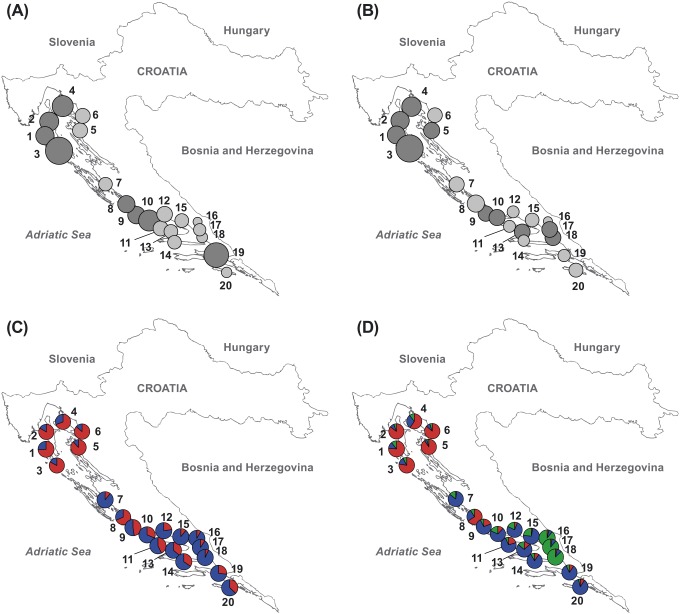
AFLP variation of Tanacetum cinerariifolium.A) Gene diversity (HE), B) Frequency down-weighted marker values (DW). In (A) and (B), the size of the circles is proportional to the depicted values (dark gray color represents values above average across populations and light gray represents values below average). C) Bayesian analysis of the population structure using the software STRUCTURE assuming K = 2, D) Bayesian analysis of the population structure using the software STRUCTURE assuming K = 3. In (C) and (D), the proportions of the ancestry of each population in each of the defined gene pools are color-coded (gene pool A red; gene pool B-blue; and gene pool C-green).